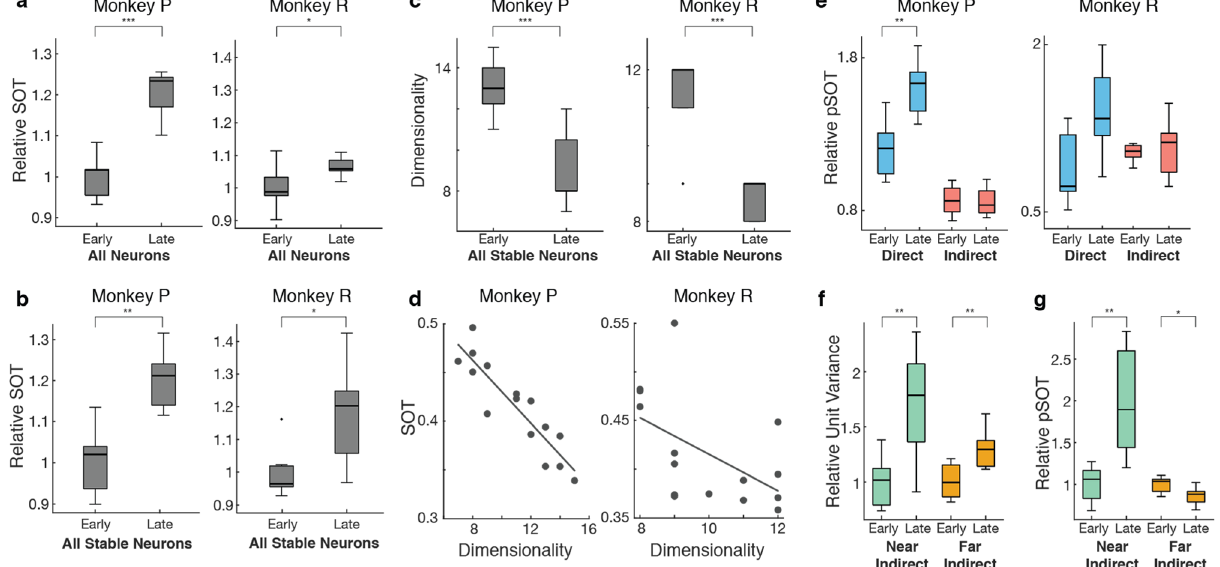
Figure 3. Increases in coordinated neural activity over learning are primarily driven by direct neurons. ( a ) The relative shared-over-total variance (SOT) ratio was calculated with respect to the mean early SOT across the entire recorded population. Relative SOT increased between early and late learning, indicating an overall increase in coordination of neural activity in the entire recorded population (Unpaired t-test; Monkey P, p = 1.31e-5; Monkey R, p = 0.033). ( b ) Relative SOT also increased between early and late learning for a stably recorded population consisting of the same units each epoch (Paired t-test; Monkey P, p = 0.002; Monkey R, p = 0.027). ( c ) Dimensionality of the neural subspace for the stably recorded population decreased from early to late learning (Unpaired t-test; Monkey P: p = 4.10e-4; Monkey R: p = 8.24e-5). ( d ) The dimensionality of the neural subspace is correlated with SOT (Linear regression; Monkey P: R 2 = 0.813, p = 4.41e-6; Monkey R: R 2 = 0.277, p = 0.044). ( e ) Respective contributions of each sub-population to the SOT ratio (pSOT, see Methods for details) were calculated in early and late learning relative to contributions in early learning. Only direct pSOT relative to early learning increased from early to late learning (Paired t-test; Monkey P, direct p = 0.003, indirect p = 0.805; Monkey R, direct p = 0.084, indirect p = 0.675). To test that the change in direct was not due to a chance grouping of neurons, we repeated the t-test 500 times while shuffling direct and indirect labels and compared the true direct t-statistic to a distribution of t-statistics from the shuffled populations (Permutation test; Monkey P, direct p = 0.014; Monkey R, direct p = 0.078). ( f ) Both near and far indirect neurons exhibited significant increases in neural variance (Unpaired t-test; near p = 0.006, far p = 0.007). ( g ) Only near indirect neurons exhibited a significant increase in pSOT relative to early learning (Unpaired t-test; p = 0.003). Far indirect neurons exhibited a significant decrease in pSOT (Unpaired t-test; p = 0.022). To test that changes in pSOT are not due to a chance grouping of neurons, we repeated the t-tests 500 times while shuffling near and far labels (Permutation test; near, p = 0.008; far, p =